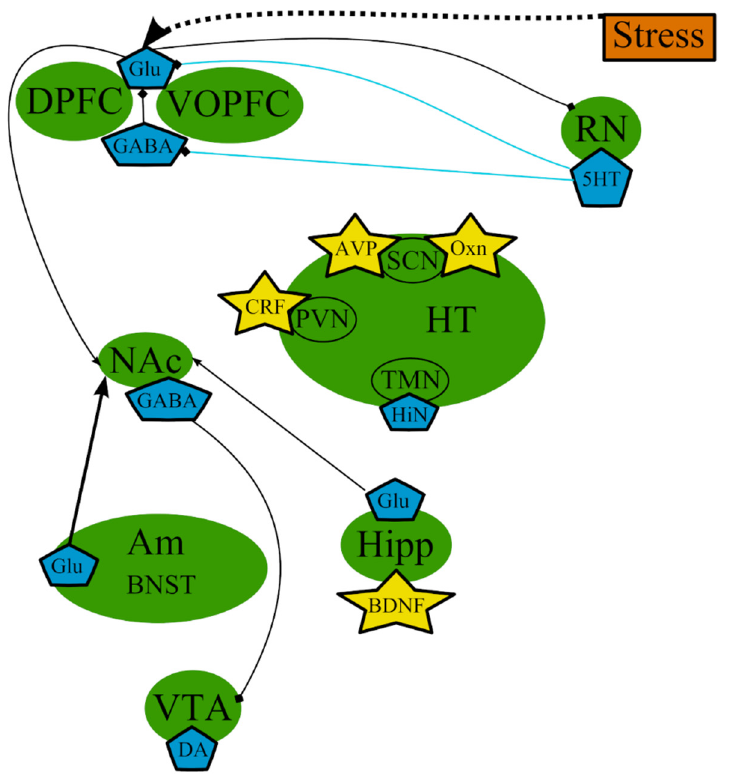
Figure 5. The excitatory neurotransmitters involved in the pathogenesis of MDD: main brain structures, neurotransmitters, biologically active substances, interactions, and external factors.